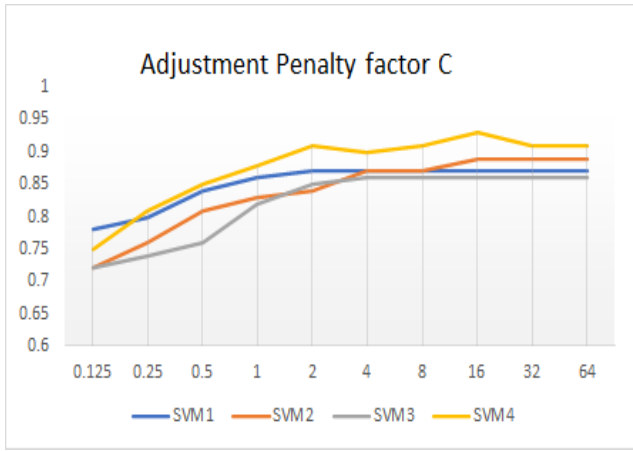
Figure 12. Penalty factor C debugging. Table 1. Compared with single image feature classifier.